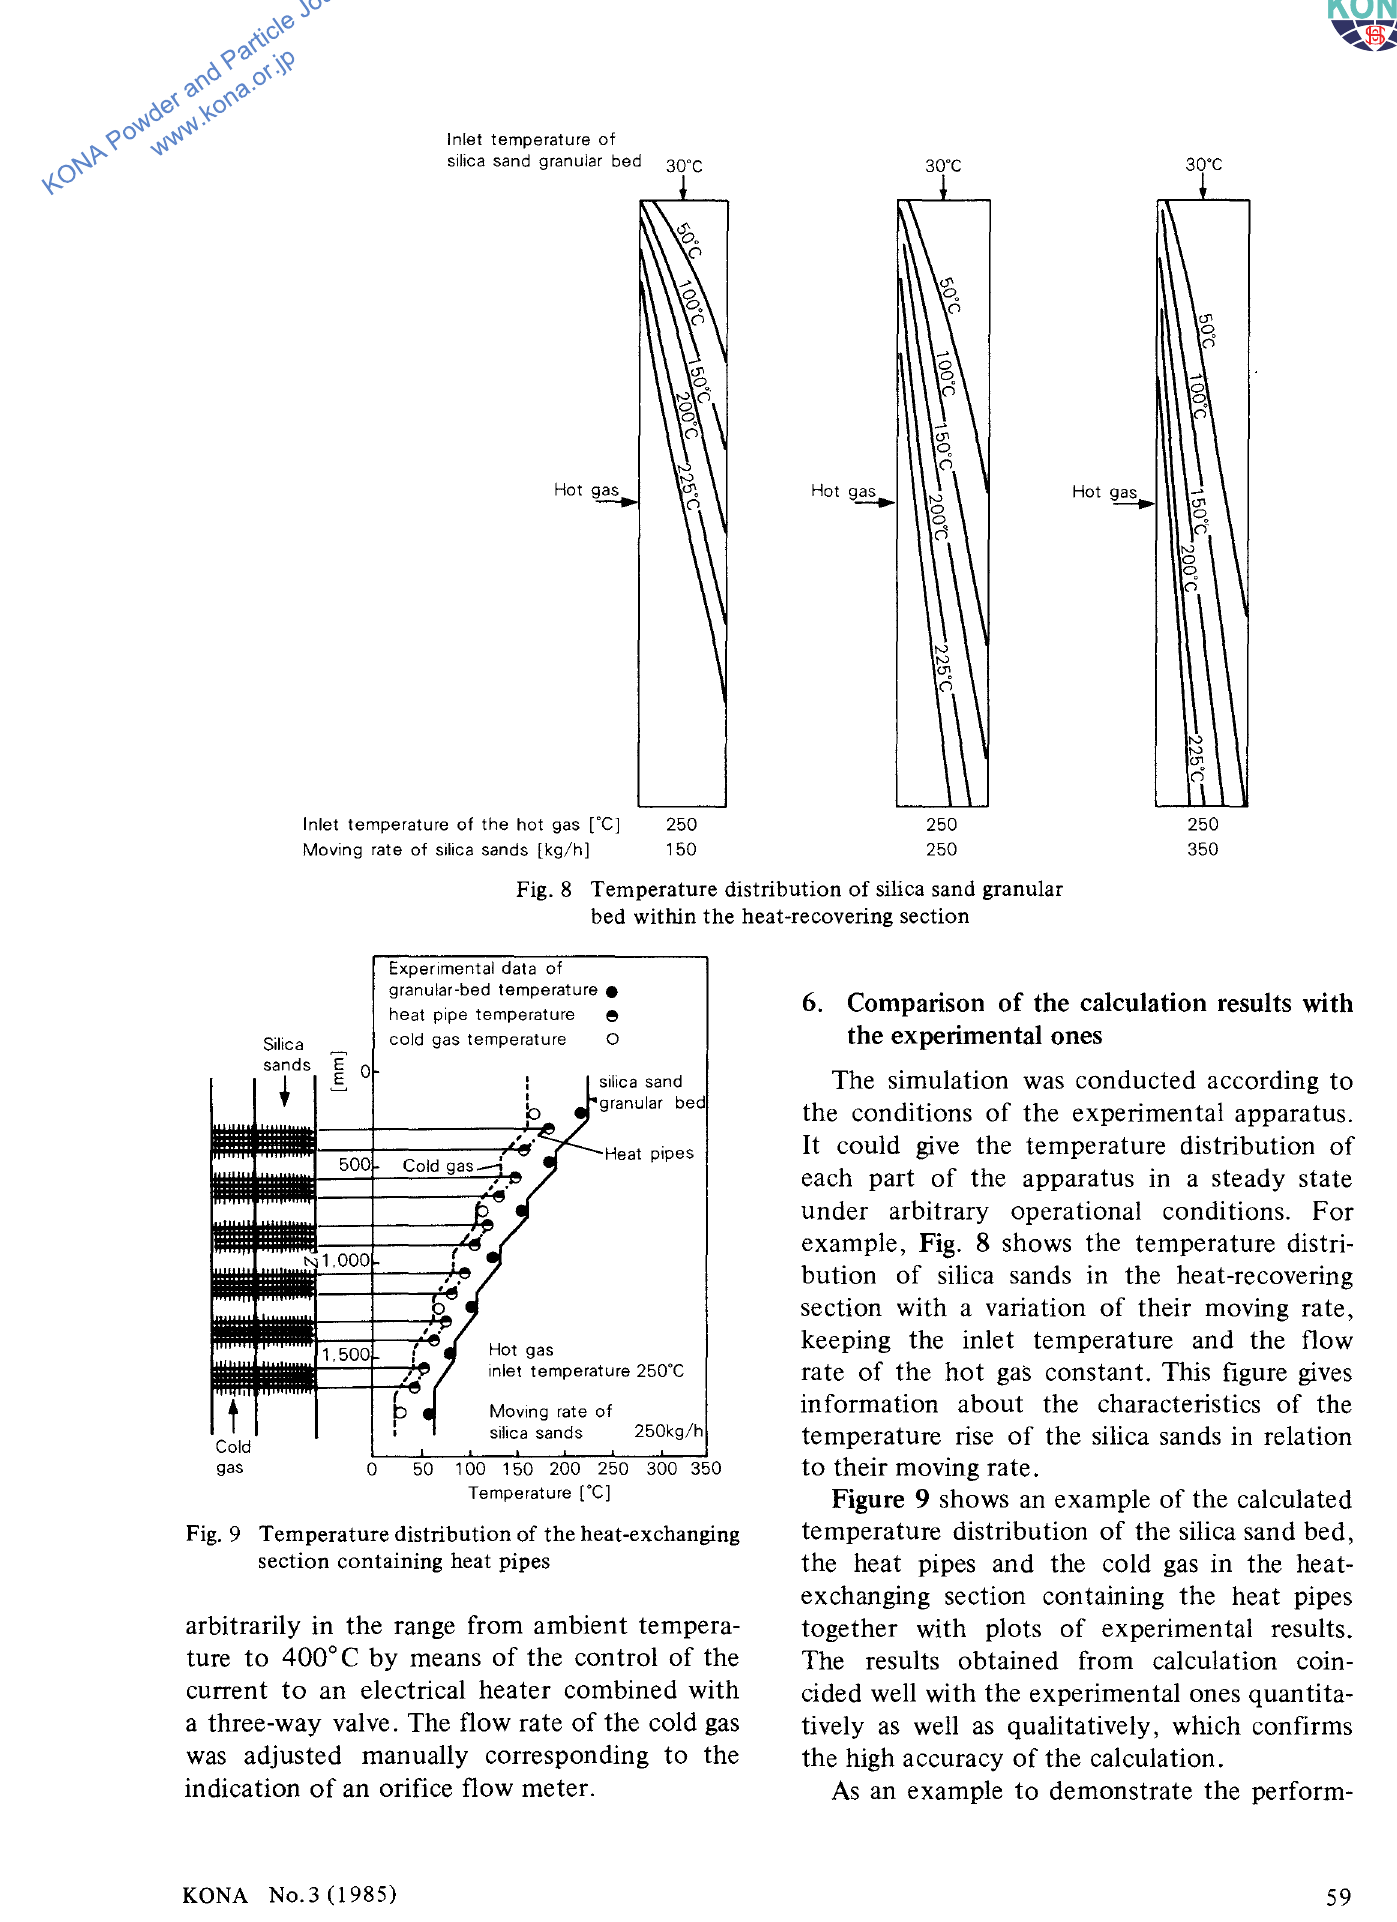
Fig. 9 Temperature distribution of the heat-exchanging section containing heat pipes arbitrarily in the range from ambient tempera ture to 400°C by means of the control of the current to an electrical heater combined with a three-way valve. The flow rate of the cold gas was adjusted manually corresponding to the indication of an orifice flow